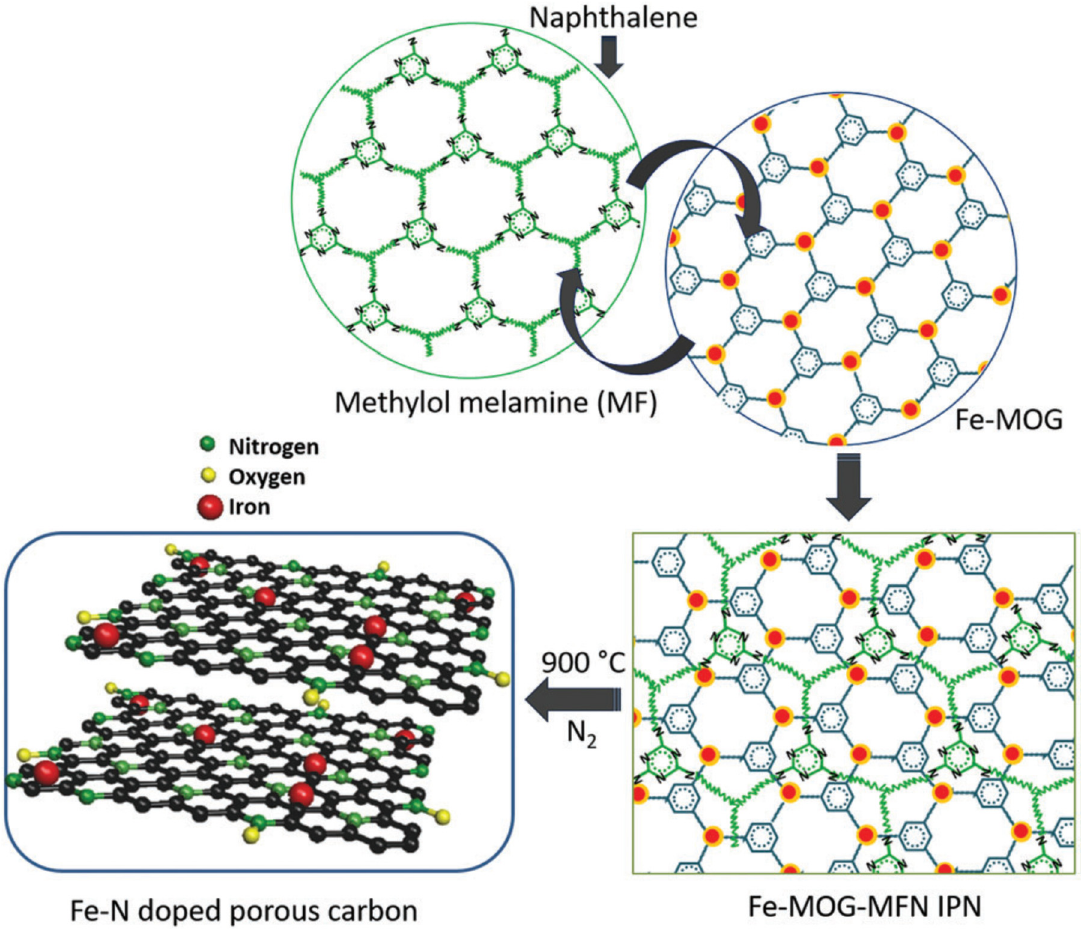
Figure 16. Schematic synthesis of Fe-MOG-MFN-C. Reprinted with permission from ref. [125]. Copyright (2018) Royal Society of Chemistry. MOG: metal–organic gel.